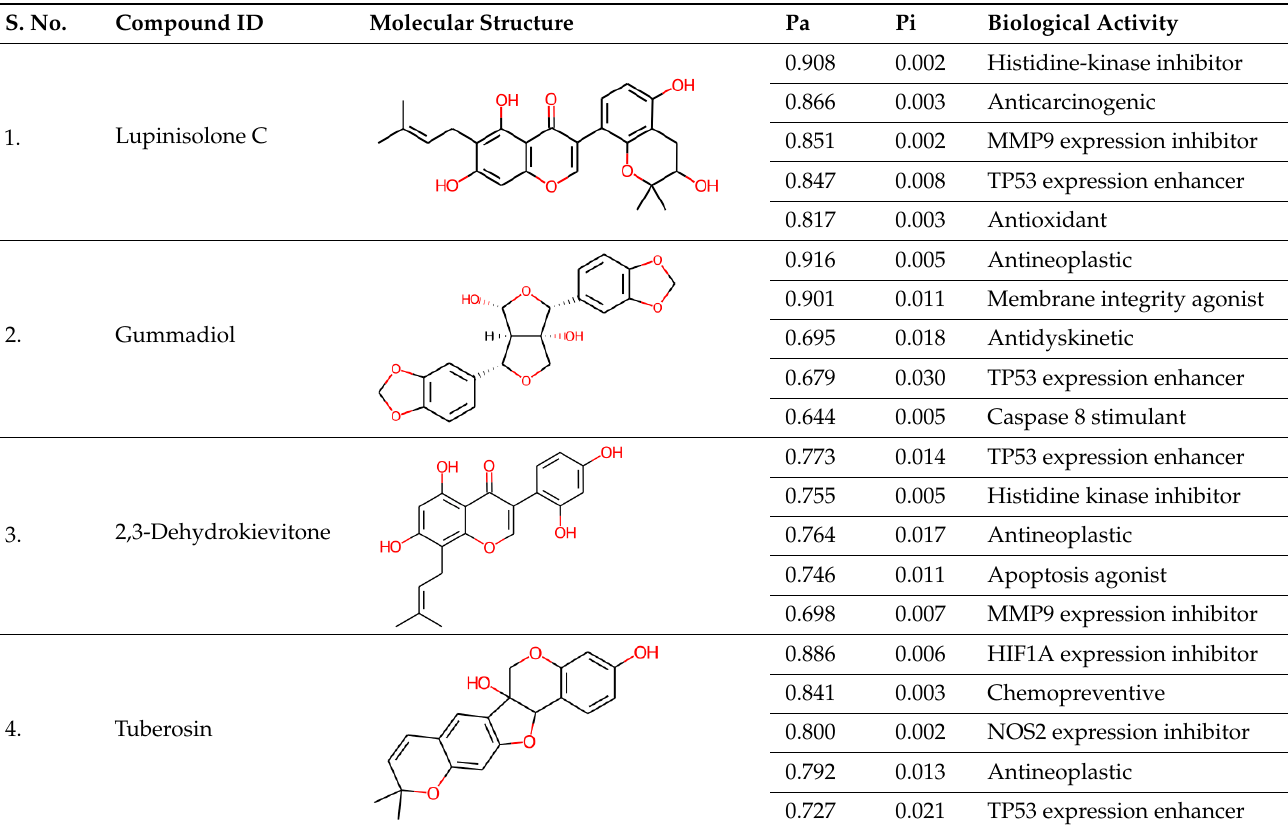
Table 3. Biological and structural properties of the selected compounds predicted through the PASS webserver Pa (probability of being active) and Pi (probability of being inactive) values signify the likelihood of activeness of a compound with a particular property.